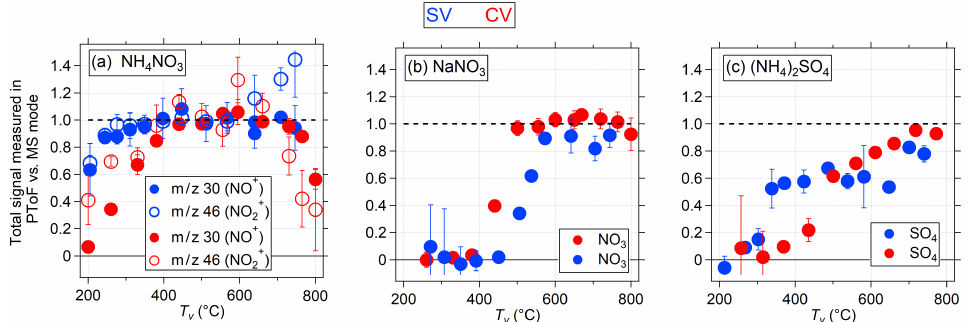
Figure 15. Ratio of total signals measured in PToF vs. MS mode for (a) (NH 4 ) 2 SO 4 , (b) NH 4 NO 3 and (c) NaNO 3 in the SV and CV as a function of T v